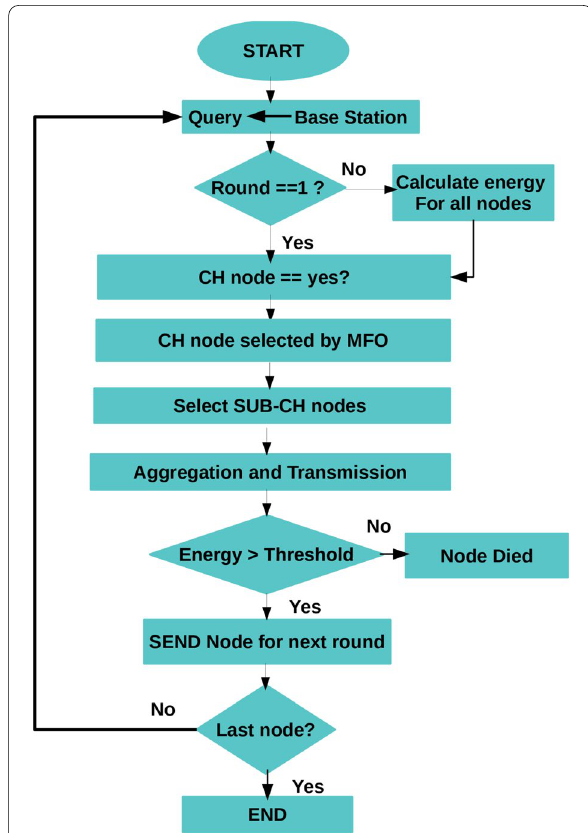
Fig. 4 Step by step representation of Sub-cluster LEACH-MFO